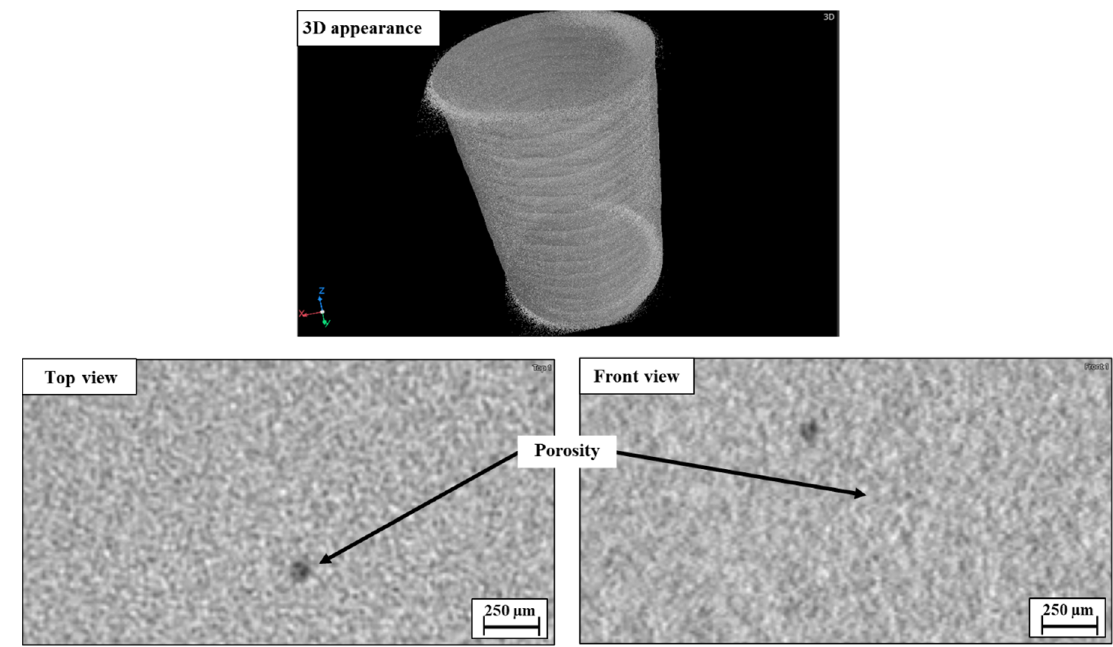
Figure 6. CT analysis of WLAM 316L alloy.